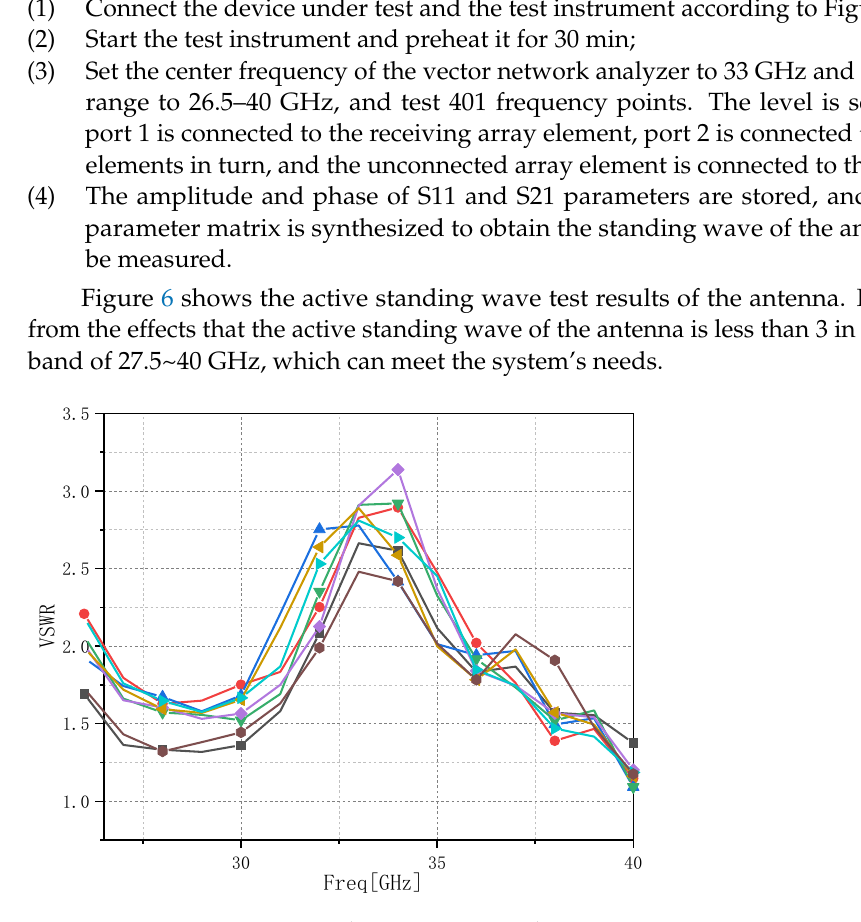
Figure 6. Ka array antenna standing wave test results.